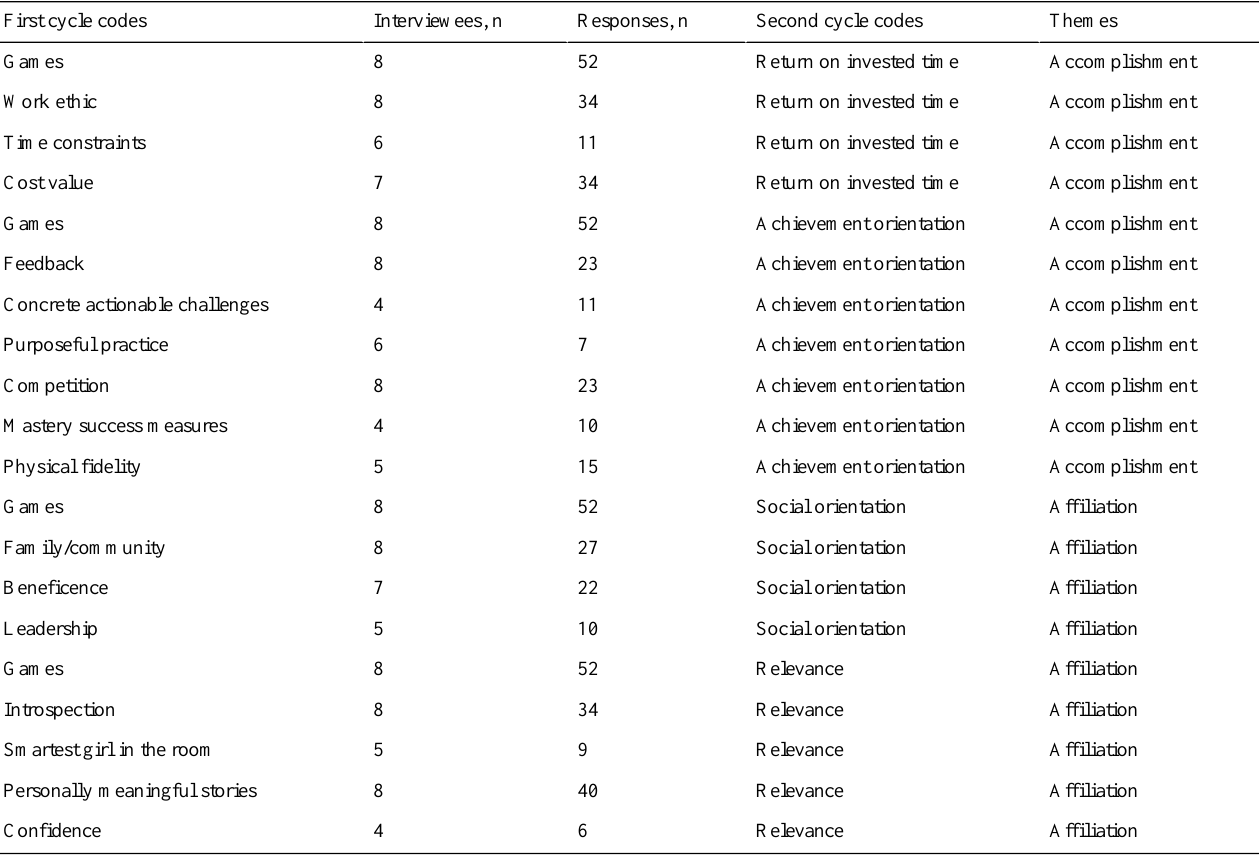
Table 2. Deductive and inductive